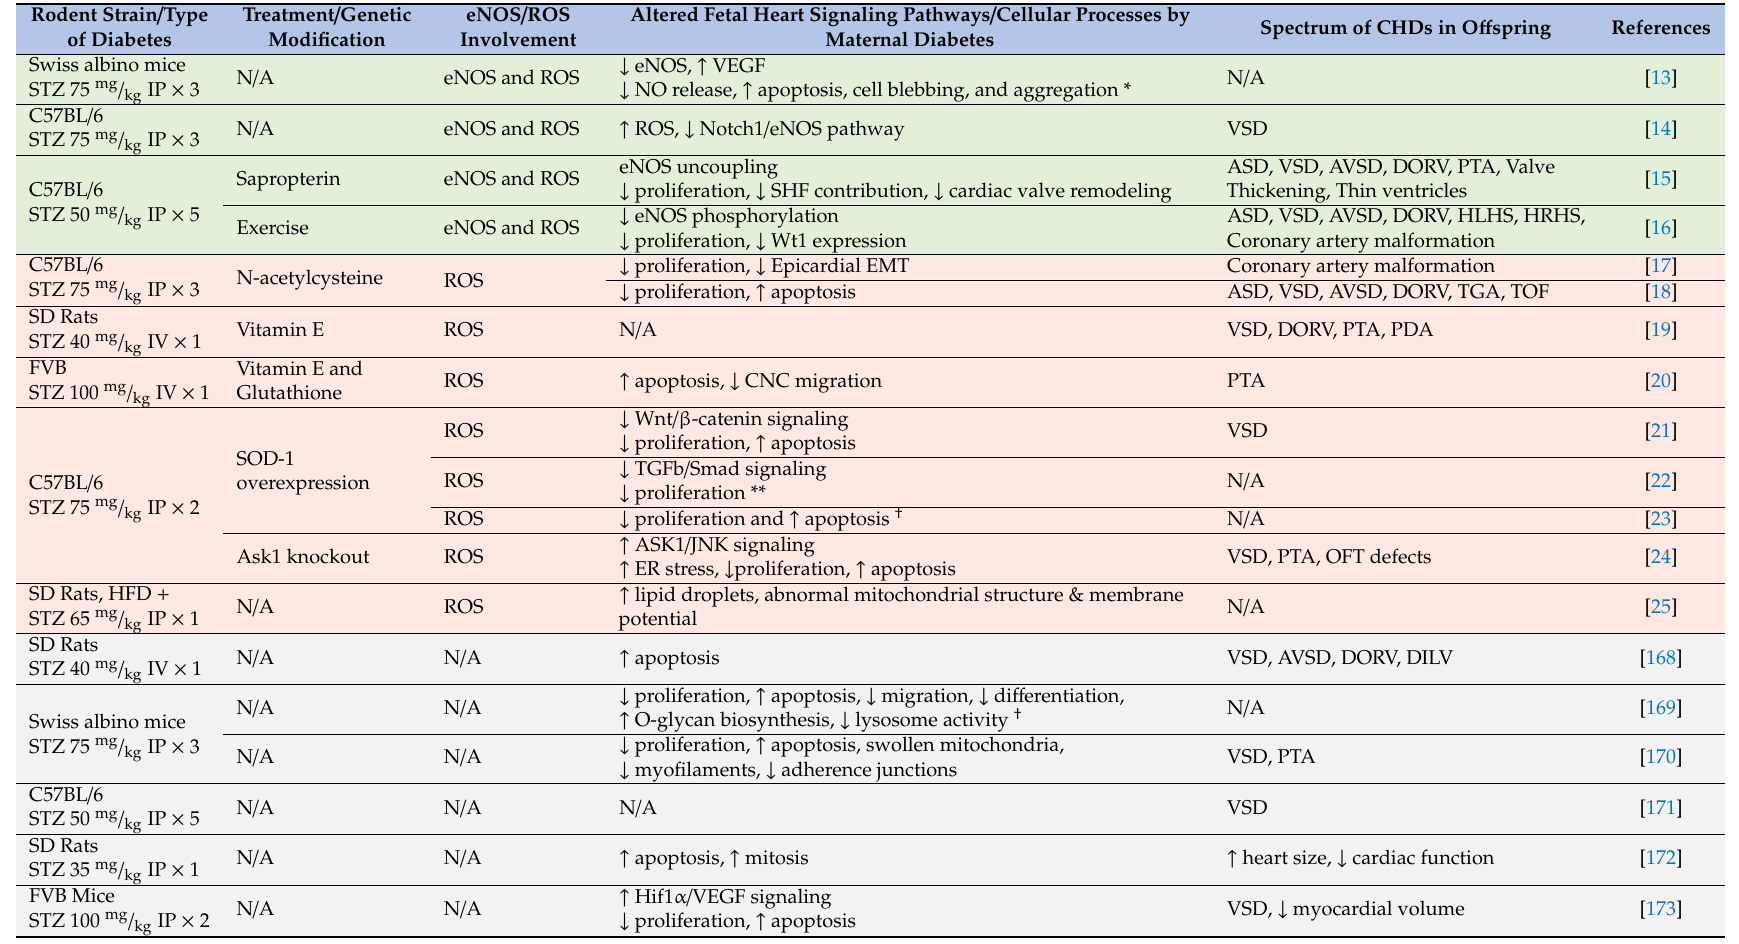
Table 1. ROS and eNOS involvement in rodent studies on pregestational diabetes-induced congenital heart